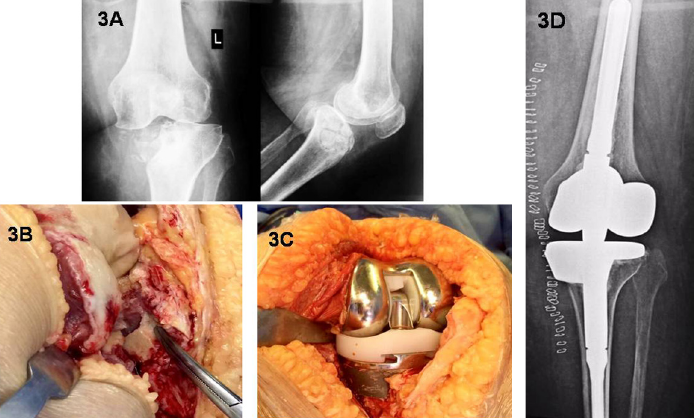
Figure 3. (A) Preoperative X-rays for a depressed fracture of the medial tibial plateau. Metaphyseal collapse and knee subluxation can be observed. (B) Intraoperative photo shows unreconstructable comminution of the articular surface. (C) The bone defect was reconstructed using a medial 20mm metal step attached to the tibial tray. (D) Postoperative X-ray showing the Rotating Hinge implant and metal augment to the proximal tibia.